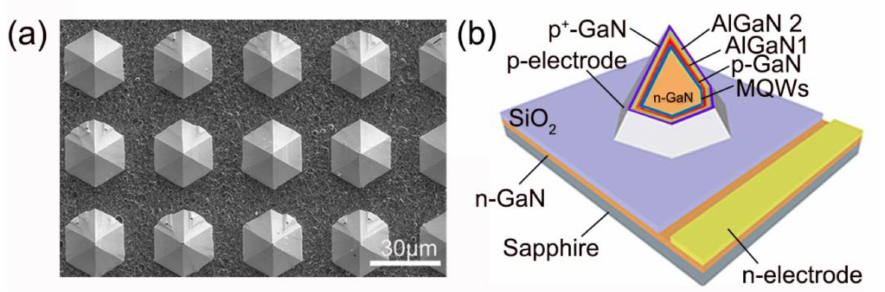
Figure 1. Top-view SEM image of the as-grown µ -LED array ( a ). Schematic illustration of the structure of a single µ -LED ( b